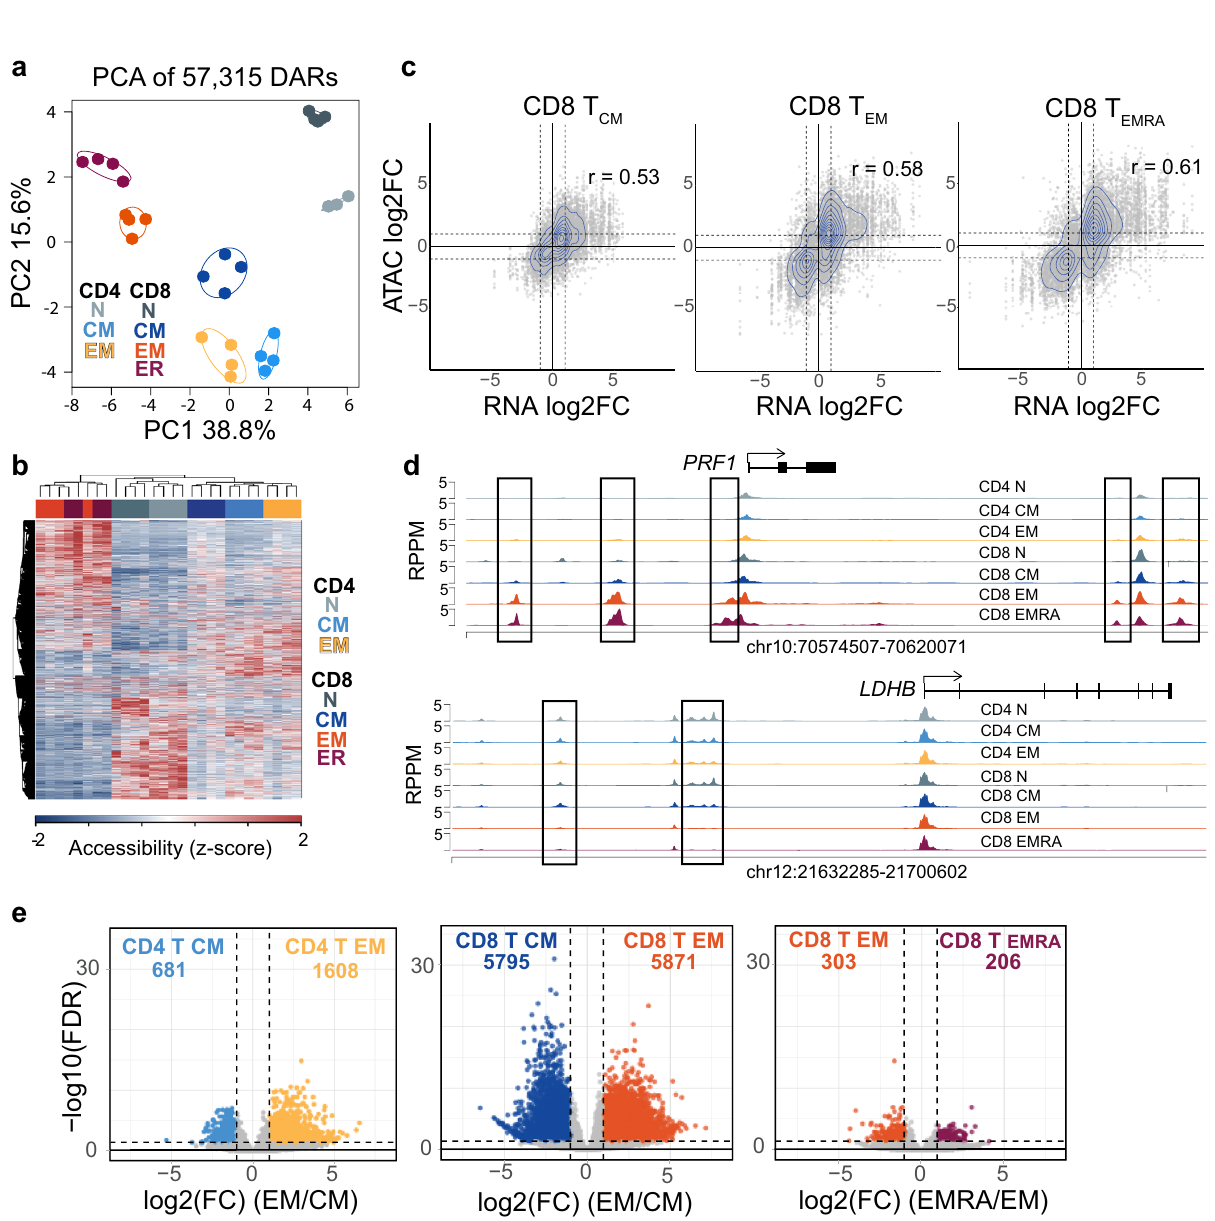
Fig. 4 Effector-memory subsets exhibit a greater number of changes to chromatin accessibility compared to central memory subsets. a PCA plot of DAR from ATAC-seq data. b Heatmap displaying DAR z-score normalized across samples. c Scatter plots showing log 2 -fold changes (FC) of MTC subsets vs. naïve T cells of DEG ( x -axis) mapped to DAR ( y -axis) for CD8 + T CM , CD8 + T EM , and CD8 + T EMRA . Dotted lines represent ±1 log 2 FC. d Genome plots showing the average accessibility levels in each of the memory subsets and naïve T cells at the indicated locus. Data represent the mean of each cell type. DAR are highlighted by boxes. e Volcano plots showing DAR that are more accessible in CD4 + T EM vs CD4 + T CM , CD8 + T EM vs CD8 + T CM , and CD8 + T EMRA vs CD8 + T EM . Number of DAR in each direction are totaled at the top of each plot.